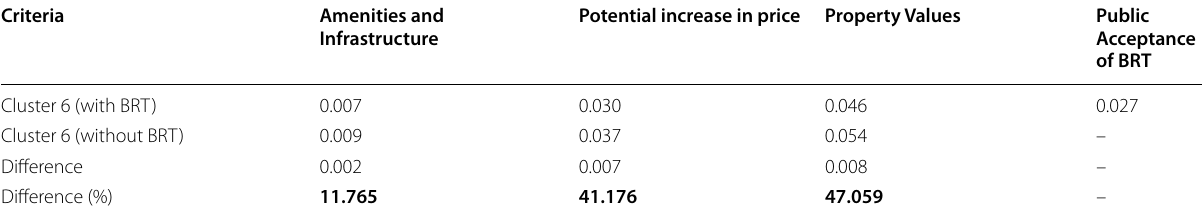
Table 7 Comparing the weighting values corresponding to cluster 6 with and without BRT Criteria Amenities and Potential increase in price Property Values Public Infrastructure